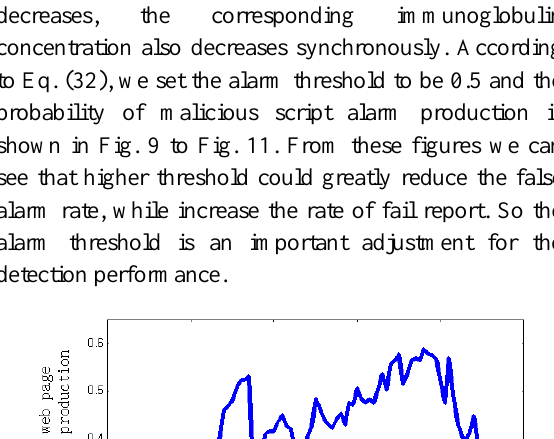
Fig. 8. Malicious VBScript spreading range and corresponding immunoglobulin concentration.